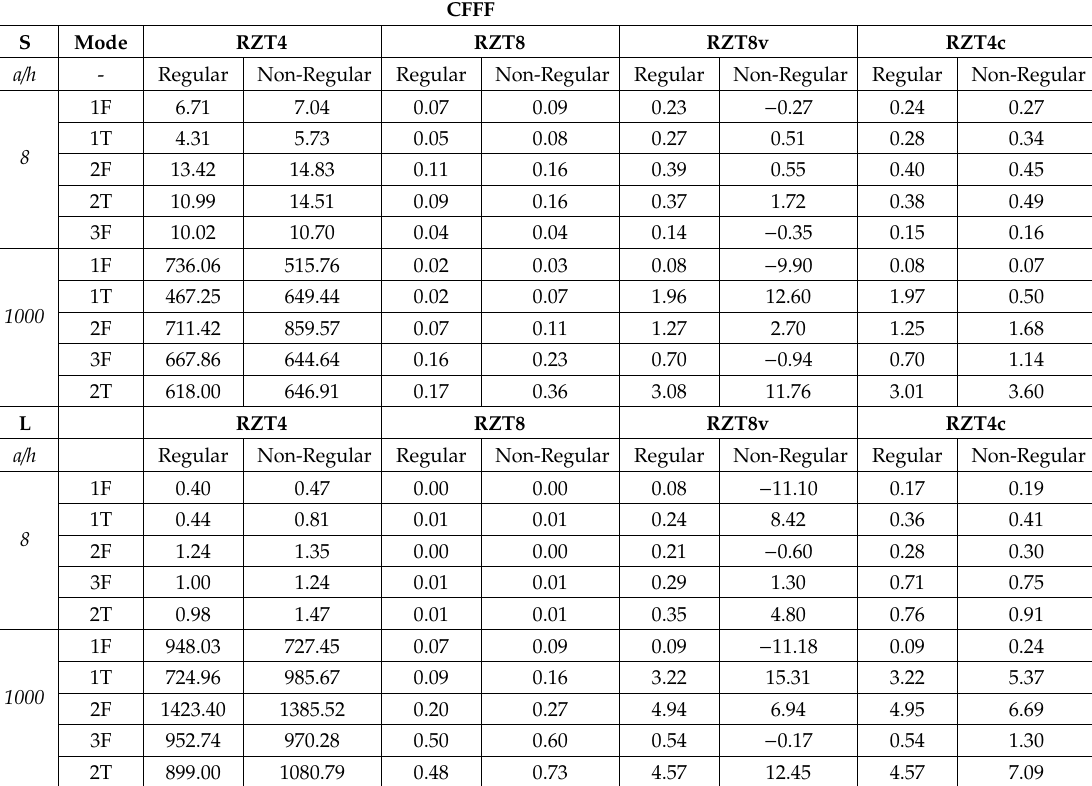
Figure 13. Load distributions for cantilever plates: ( a ) Uniform pressure (C1), ( b ) uniform pressure along the free edge (C2), ( c ) two opposite vertical forces (C3). Table 9. Percent errors of FEM results on the undamped frequency parameter of thick ( a / h = 8) and very thin ( a / h = 10 3 ) square plates. Regular and distorted 16 × 16 mesh (Figure 11). F (Flexural mode), T (Torsional